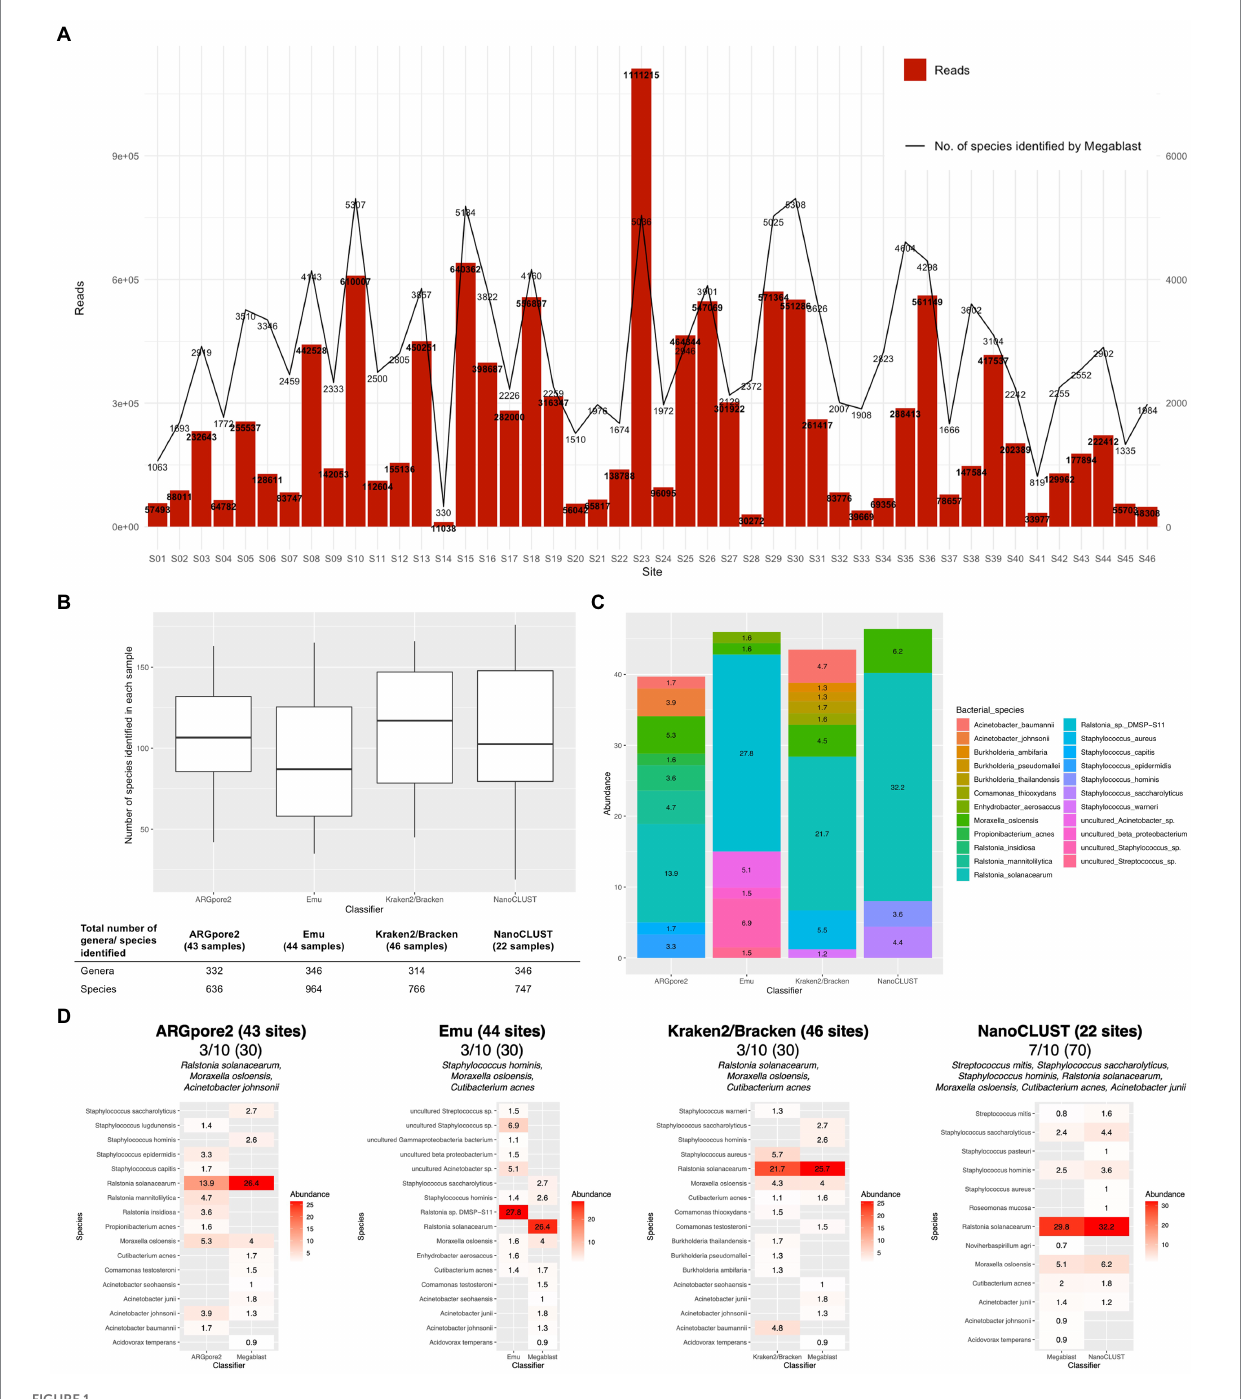
FIGURE 1 Species-level taxonomic assignment of the urban samples. (A) Total number of reads in each site and the number of species classified by MegaBLAST. (B) The number of bacterial species and genera in each sample identified by ARGpore2, Emu, Kraken2/Bracken, and NanoCLUST. (C) Average abundance of dominant species classified by ARGpore2, Emu, Kraken2/Bracken, and NanoCLUST. (D) Comparison of the top 10 dominant species between MegaBLAST and the four